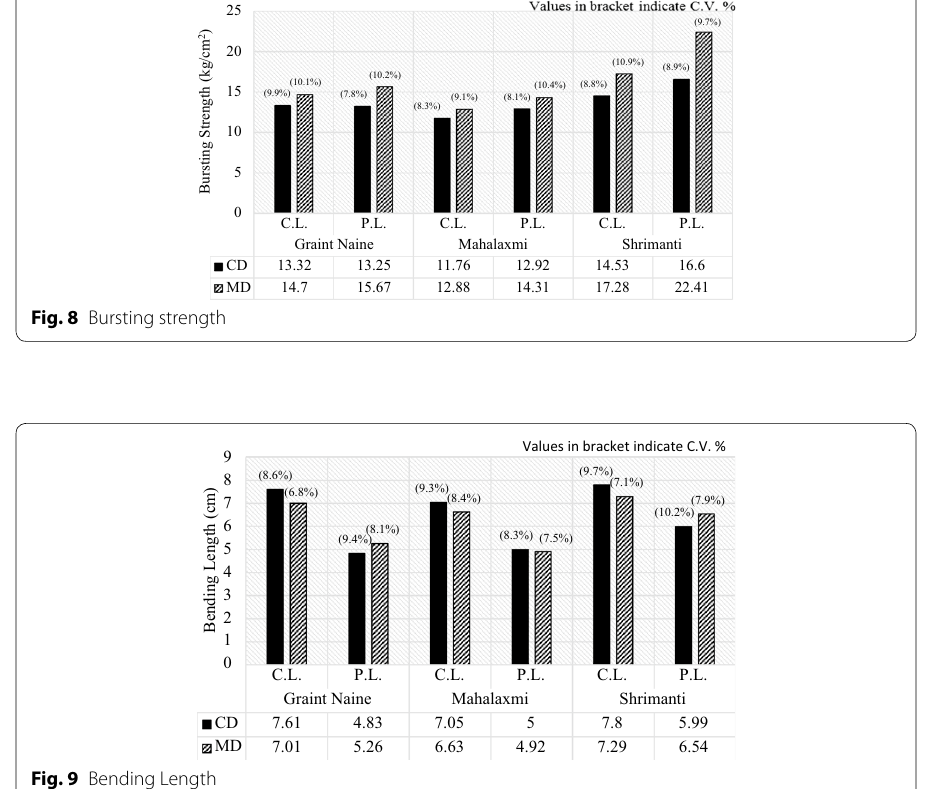
The C.L. nonwoven fabric shows lower bursting strength compared to P.L. fabric for all three varieties of banana fibre nonwoven fabric in the M.D. as well as in C.D. More regu- lar P.L. non-woven fabric structure may be contributing for higher bursting strength in comparison with C.L. structure. From the statistical analysis (Table 4) it can be observed fabric. Banana fabric type (P.L. structure and C.L. structure) have a significant effect on bursting strength of non-woven fabric and test direction i.e. M.D. and C.D. have a sig- nificant effect on bursting strength of non-woven fabric.